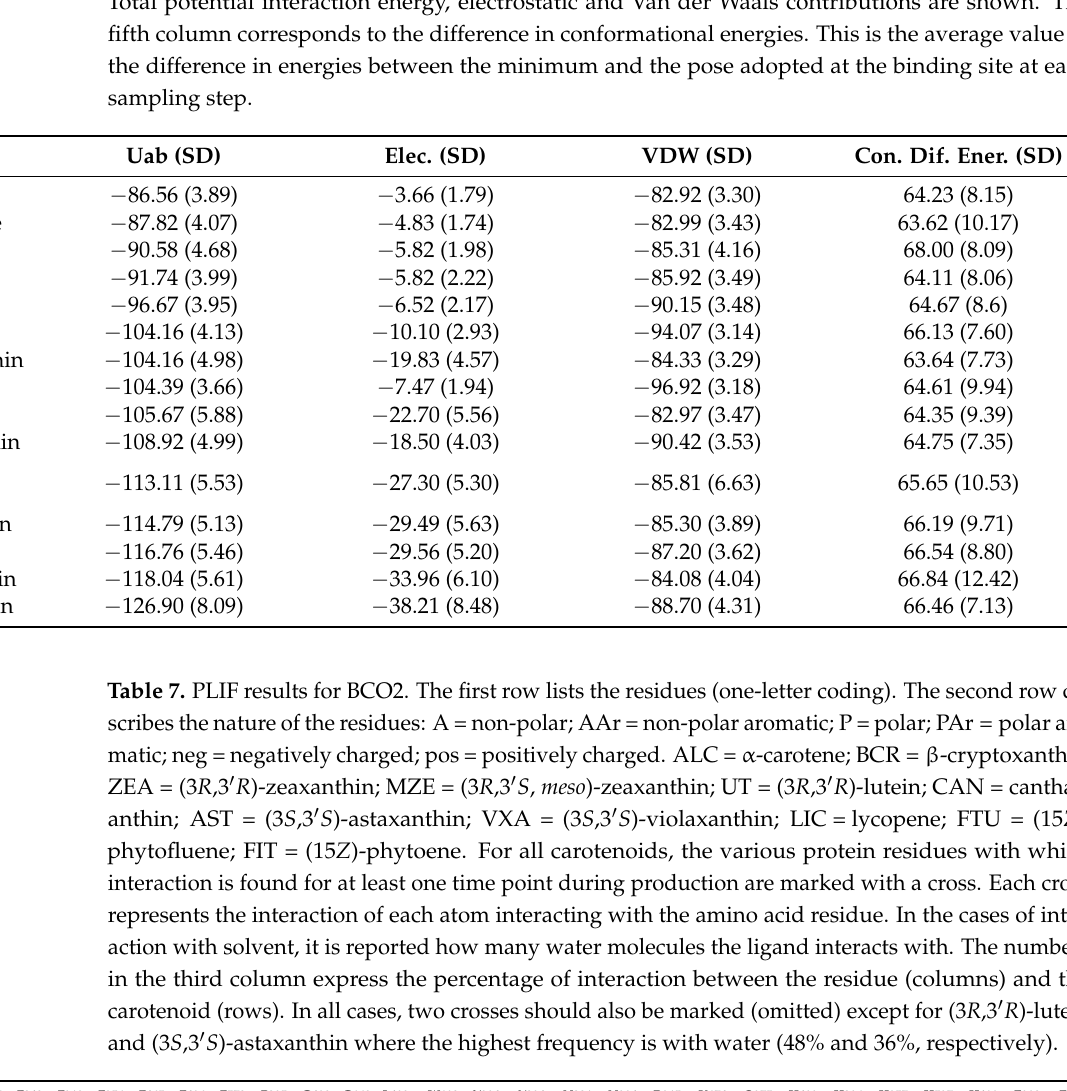
pos neg neg neg neg neg neg